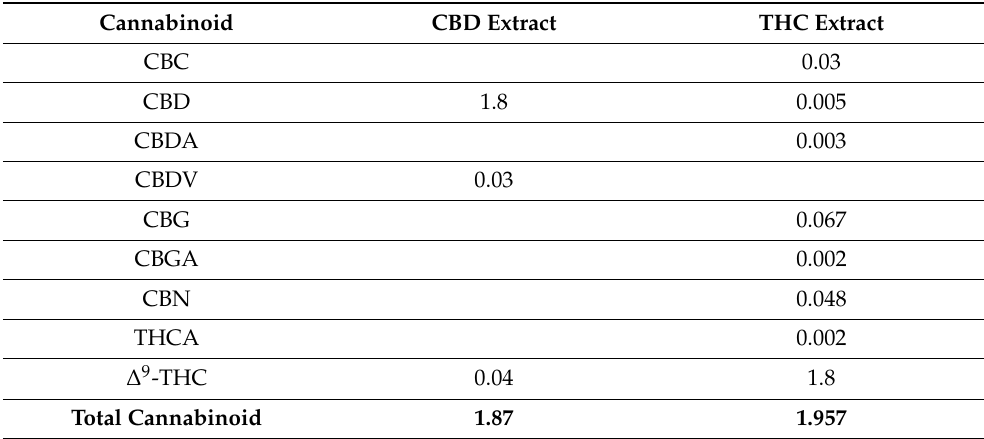
Table 2. Cannabinoid composition of extracts as administered to mice; concentrations are in mg/mL. Cells with no values represent assay results below the level of detection.